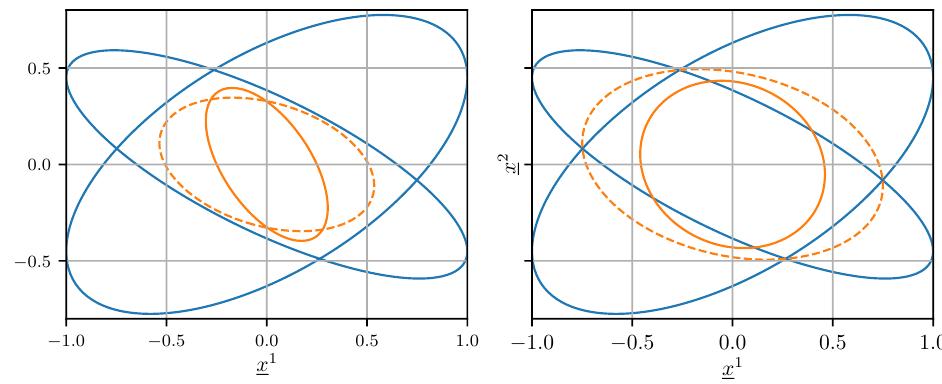
Figure 2. Confidence ellipsoids of C aa and C bb (blue), C ( x f = 0 . The result obtained using optimal fusion with the erroneous assumption dashed) when C ab (cid:54) C ab = 0 is shown on the left. The result achieved using CI is shown on the